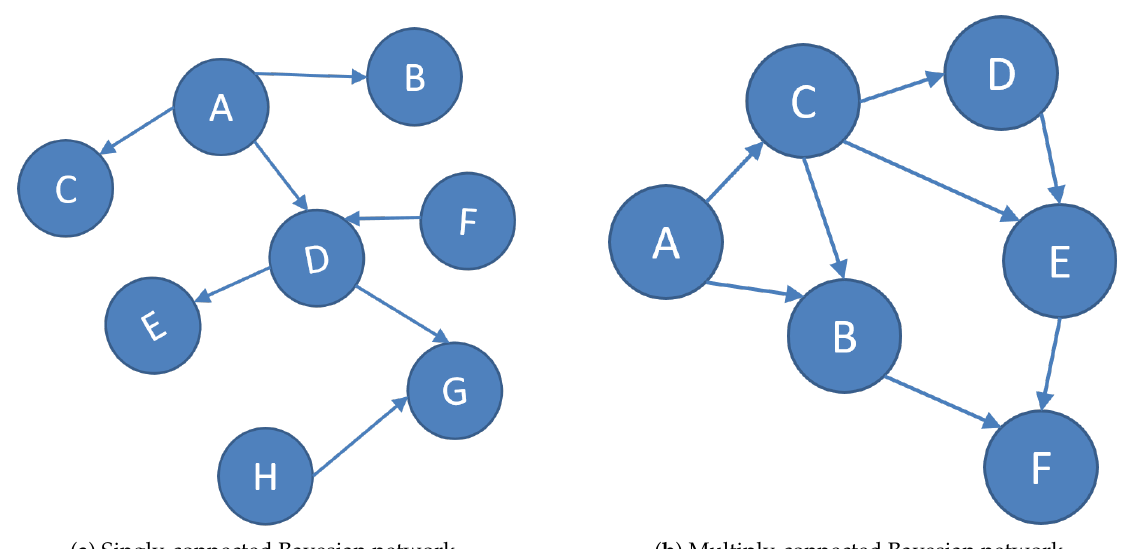
Figure 1. Singly-connected and multiply-connected Bayesian